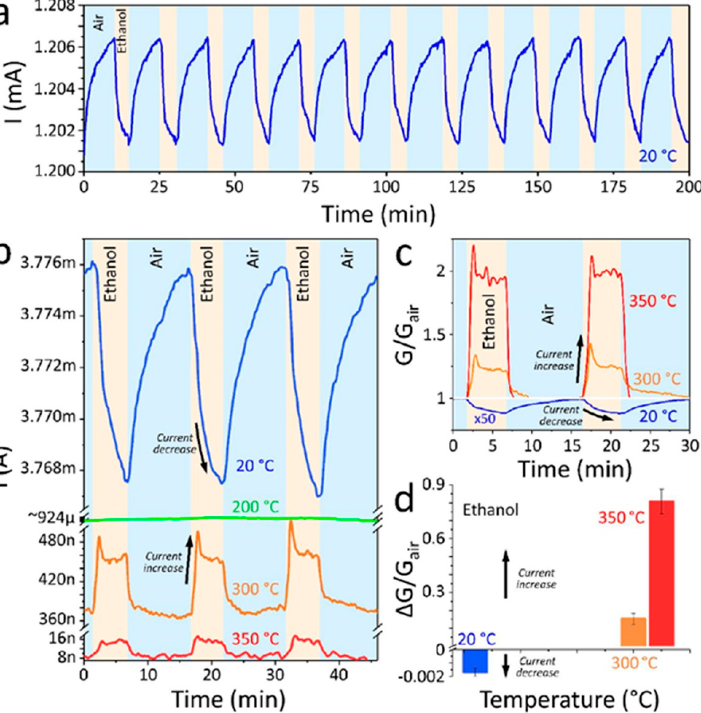
Figure 11. Sensor behavior of Ti 3 C 2 T x MXene annealed at different temperatures. All panels show sensor responses to 250 ppm ethanol. The voltage applied between the device contacts was 1V. ( a ) Stability of sensor responses of pristine Ti 3 C 2 T x MXene measured at RT (20 °C). ( b ) Responses of a MXene sensor element that was measured at RT (20 °C; blue curve) and then annealed at 200 °C (green curve), 300 °C (orange curve), and 350 °C (red curve). After each annealing, the sensor measurements were performed at the annealing temperature. ( c ) Normalized sensor responses at different temperatures for the same MXene sensor element. The responses for the pristine metallic MXene are multiplied by 50 to be visible on the figure scale. ( d ) Comparison of sensor responses at different temperatures for the same MXene sensor element. Reprinted with permission from [105]. Copyright